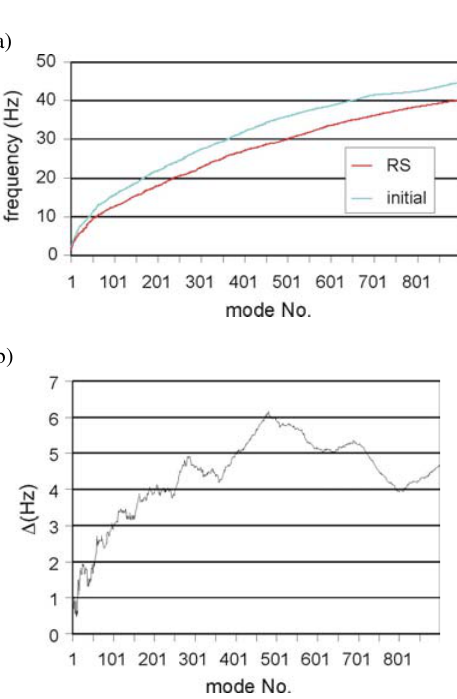
Fig. 10. Comparison of frequencies (a) and absolute diffe- rence between frequencies (b) obtained for stiffness and initial